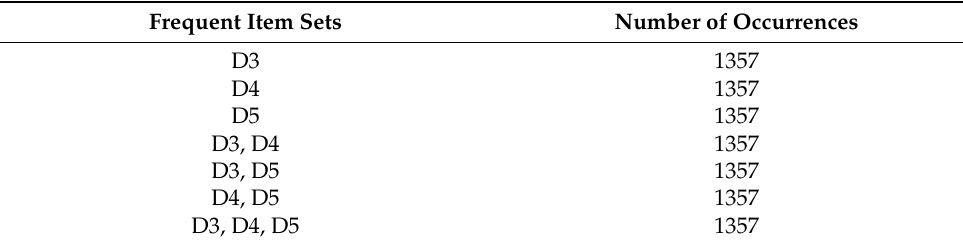
Table 5. The frequent item sets of the system (example